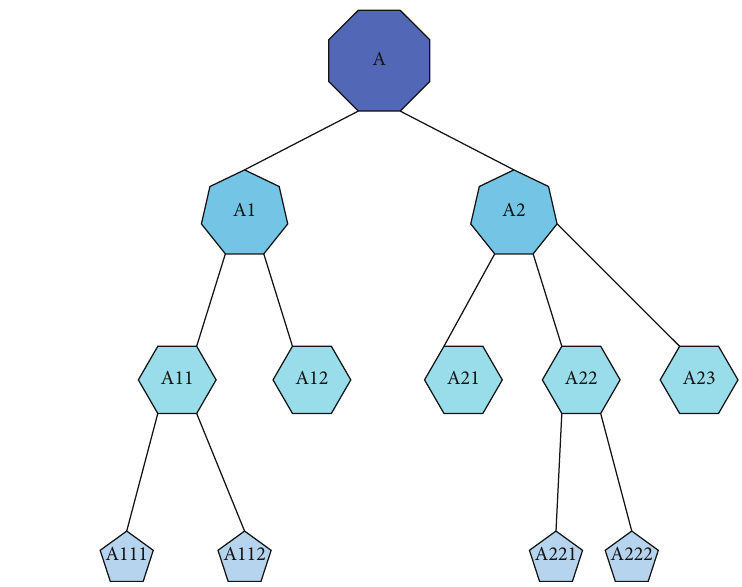
Figure 2: Graphical representation of the tree.